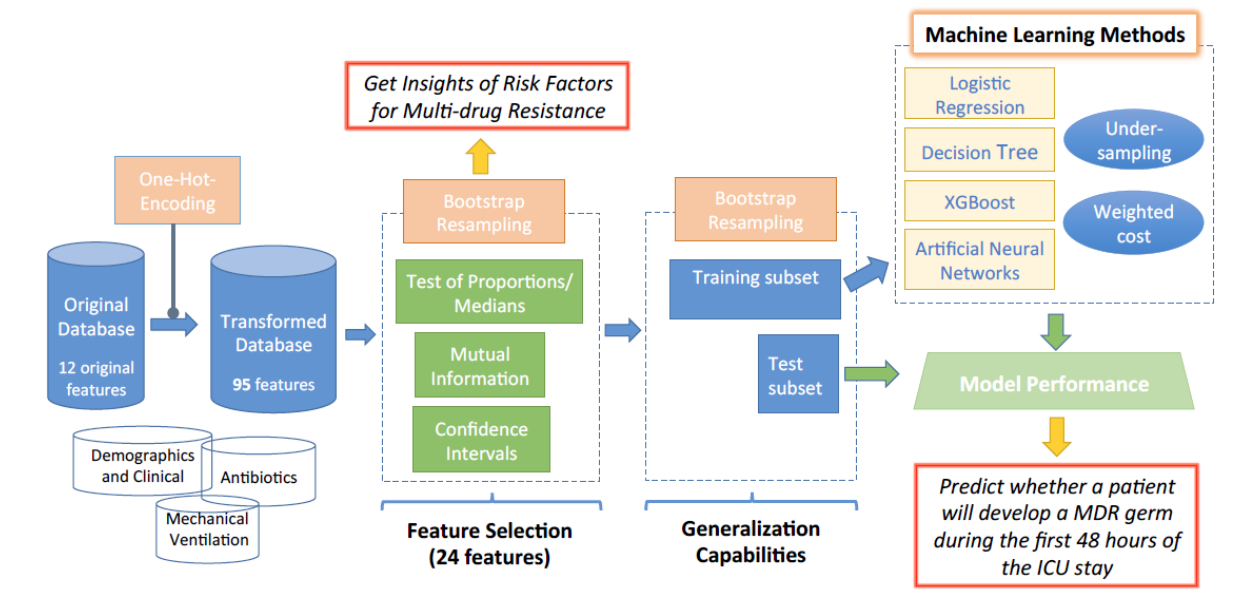
Figure 1. Workflow diagram of the proposed methodology to get insights of multi-drug resistance (MDR) risk factors and to predict whether a patient will develop an MDR germ during the first hours from the Intensive Care Unit (ICU)